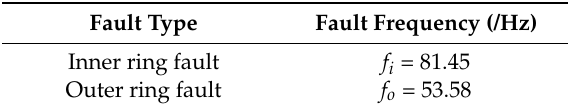
Table 3. Characteristic frequencies of FAFNIR deep groove rolling bearing.